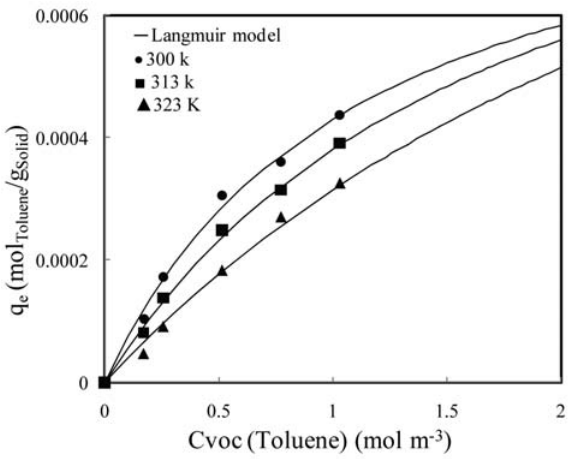
Figure. 8 . Effect of temperature on the adsorption capacity of FS natural clay toward